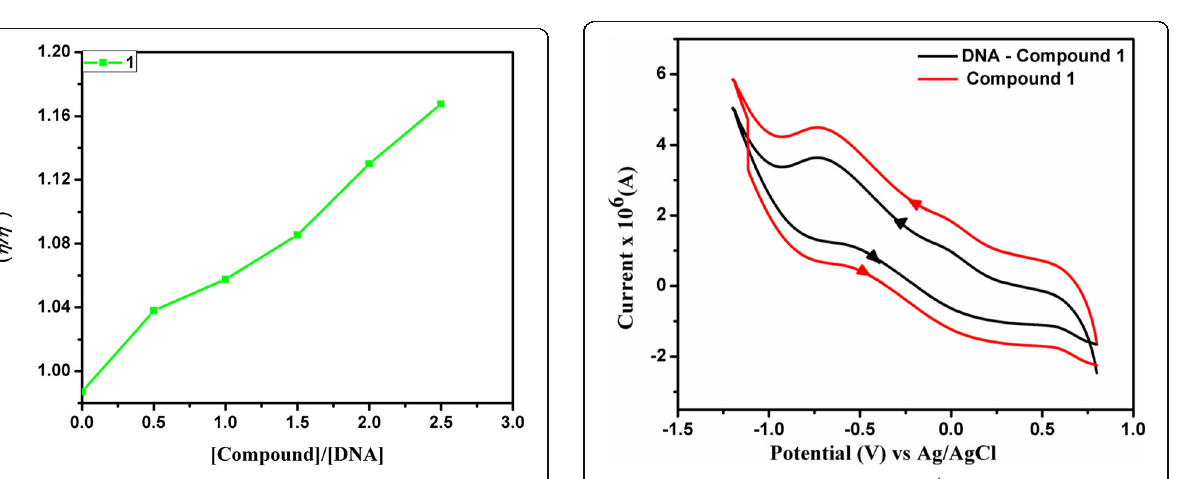
Fig. 2 Effect of increasing amounts of test compound (1) on the relative viscosity of DNA at pH 7.4 and 25 °C, [DNA] = 2.5 × 10 − 5 M and [Compound] = (0.4 – 2.0 × 10 − 5 M)